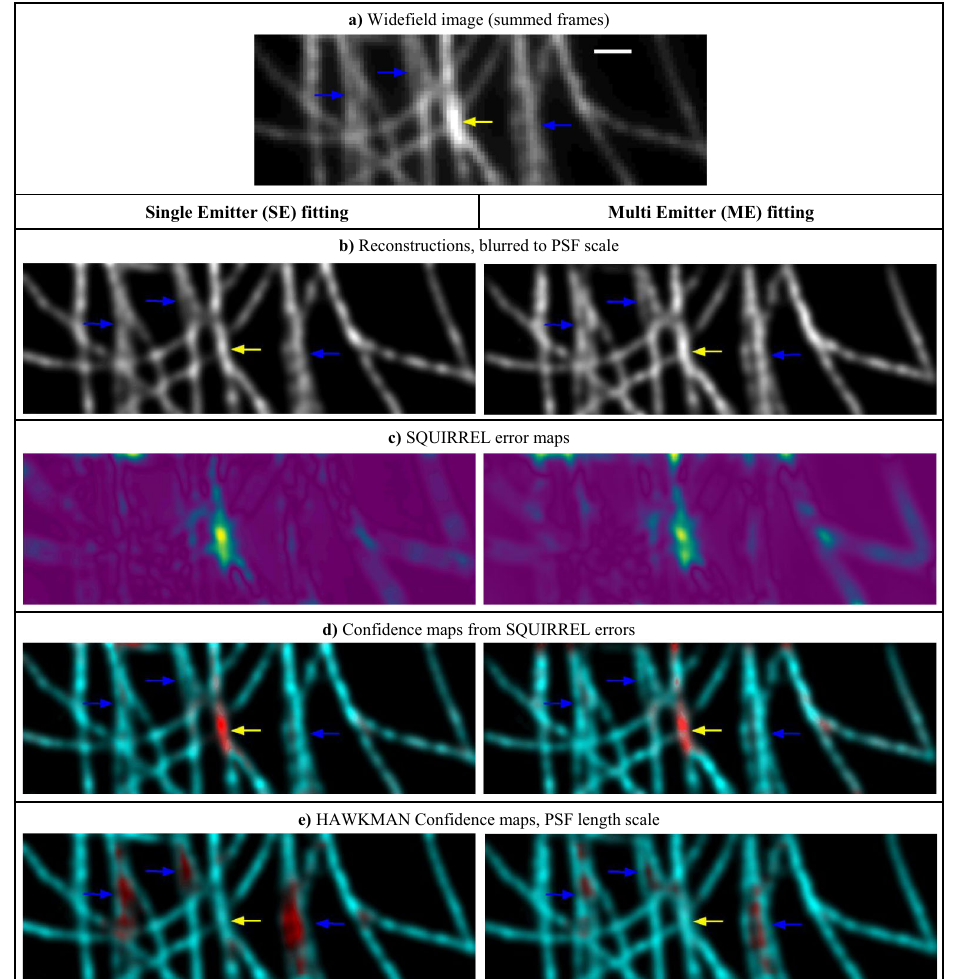
Fig. 4 Comparison of the ability of SQUIRREL and HAWKMAN to detect structural artefacts when faced with intensity differences in the input and reference images, on experimental high density data from the Localisation Microscopy Challenge. a A pseudo wide fi eld image produced by summing image frames. b SE and ME reconstructions. Blue arrows indicate areas of obvious sharpening compared to the wide fi eld, the yellow arrow denotes an area of high intensity. c Error maps produce by SQUIRREL analysis show the largest errors (yellow) are dominated by the high intensity region in ( a ). The relative error is used instead of the con fi dence score to produce a HAWKMAN style con fi dence map ( d ) from the SQUIRREL data. When compared to the actual HAWKMAN result ( e ), it shows SQUIRREL principally detects the intensity differences and does not recognise the superior structural details (blue arrows) of the ME reconstruction. Scale bar 1 µ